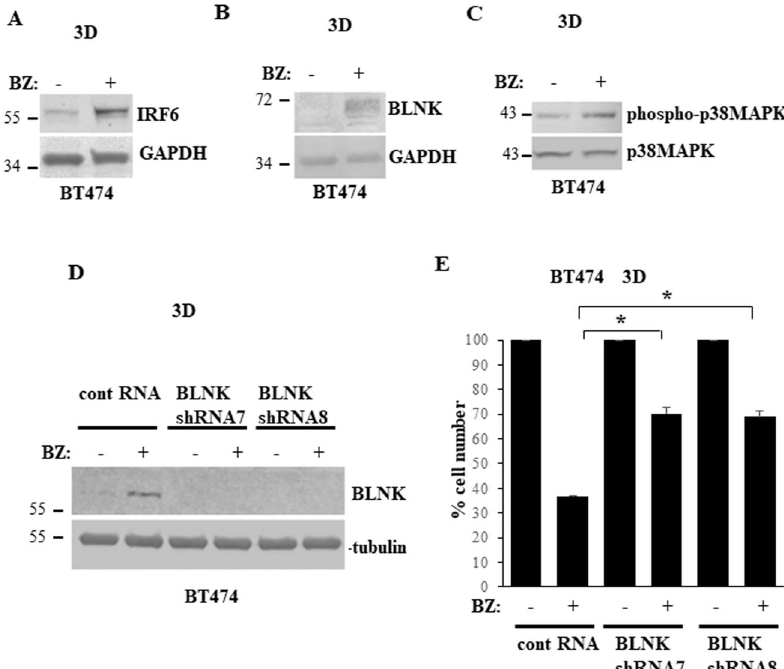
Fig. 7 Bortezomib causes BLNK-dependent anoikis of ErbB2-overproducing breast cancer cells. A , B BT474 cells were cultured detached from the ECM (3D) for 48 h in the absence ( − ) or in the presence ( + ) of 100 nM bortezomib (BZ) and assayed for IRF6 ( A ), BLNK ( B ) and phospho-p38MAPK ( C ) expression by western blotting. GAPDH was used as a loading control in (A, B) and total p38MAPK, in C . D BT474 cells were infected with a control lentivirus or that encoding BLNK shRNA (BLNKshRNA) 7 or 8, cultured for 24 h in the absence ( − ) or in the presence ( + ) of 100 nM bortezomib (BZ) detached from the ECM (3D) and assayed for BLNK expression by western blotting. α -tubulin was used as a loading control. E BT474 cells were treated as in C , cultured detached from the ECM (3D) for 120 h in the absence ( − ) or in the presence ( + ) of 100 nM bortezomib (BZ) and counted. The number of control cells was designated as 100%. The data are the average of the three independent experiments plus the SD. * p -value <